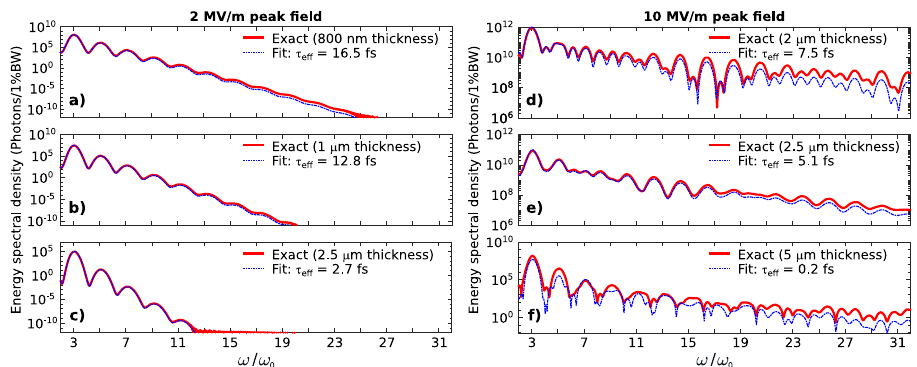
Fig. 4 Effective propagation-induced dephasing in THz HHG. For all panels, we plot the exact output HHG spectrum computed via Maxwell ’ s equations as solid red curves, and the output HHG spectrum computed via Eq. (1) fi tted to an effective scattering time τ eff — while neglecting propagation effects — as blue dashed-dotted curves. a, b, c show the spectra when 3D DSM fi lms of thicknesses 0.8 μ m, 1 μ m, and 2.5 μ m, respectively are driven by a peak fi eld of 2 MV/m. d, e, f show the spectra for fi lm thicknesses of 2 μ m, 2.5 μ m, and 5 μ m respectively, driven by a peak fi eld of 10 MV/m. Our fi tted values of τ eff are in good agreement with the exact spectra, implying that the reduced HHG can be captured by an effective dephasing time and is thus due to propagation- induced dephasing effects. As expected, larger fi lm thicknesses correspond to shorter τ eff . We consider the same parameters as in Figs. 1 and 3. Here, we normalize all angular frequencies of the output ω against the fundamental driving frequency ω